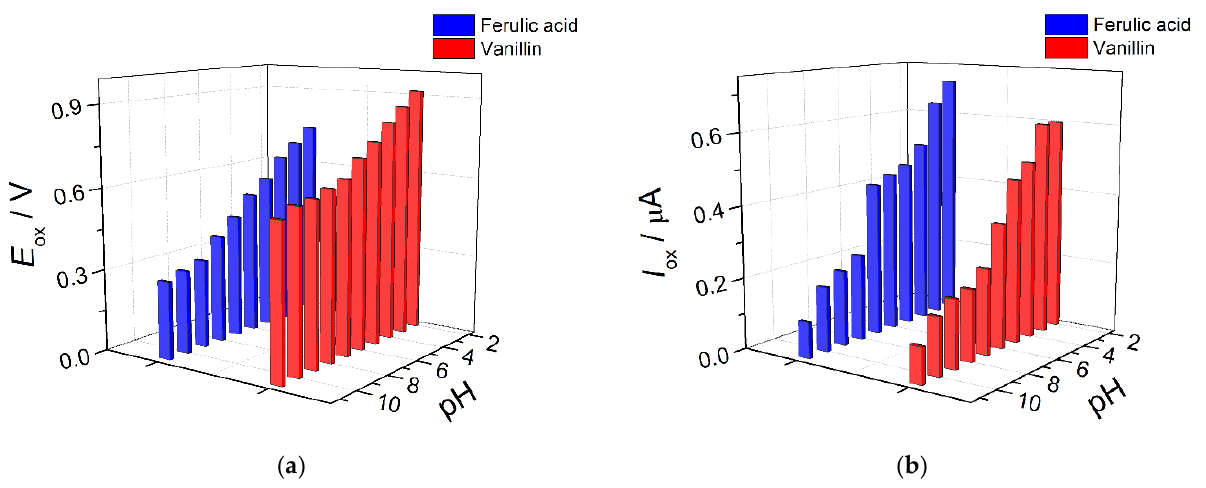
Figure 9. Effect of supporting electrolyte pH on the oxidation potentials ( a ) and currents ( b ) of 10 µM ferulic acid and vanillin on polyBCP/f-SWCNTs/GCE; υ = 100 mV s ‒ 1 .